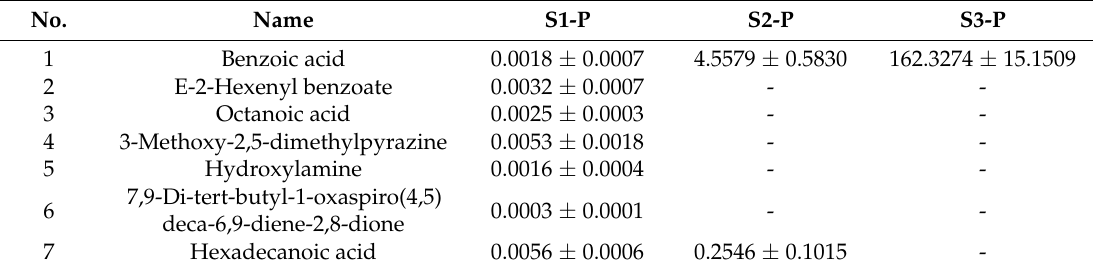
Table 3. The floral volatile organic compounds detected in L. longituba